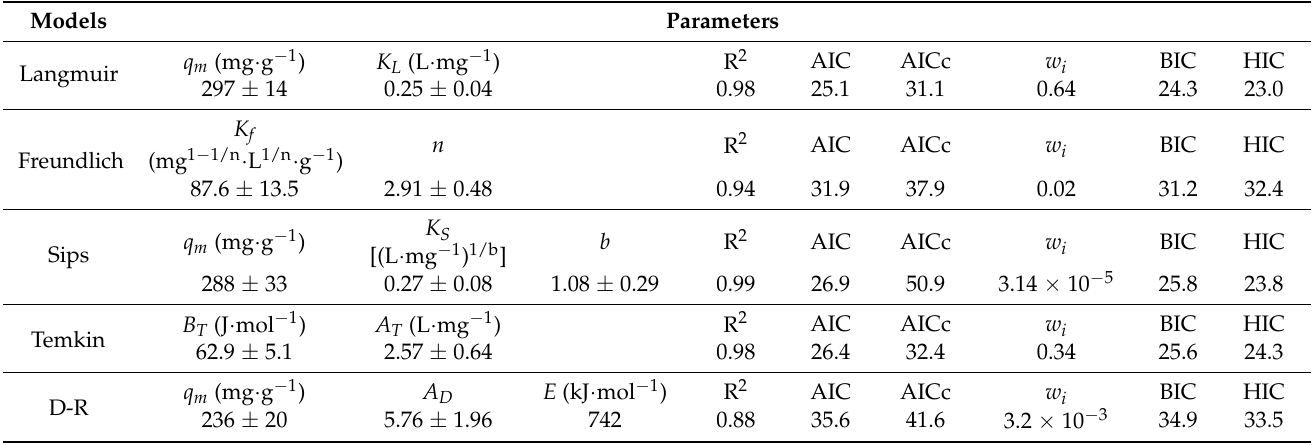
Table 4. Results for parameters and the information criterion determination of isotherm